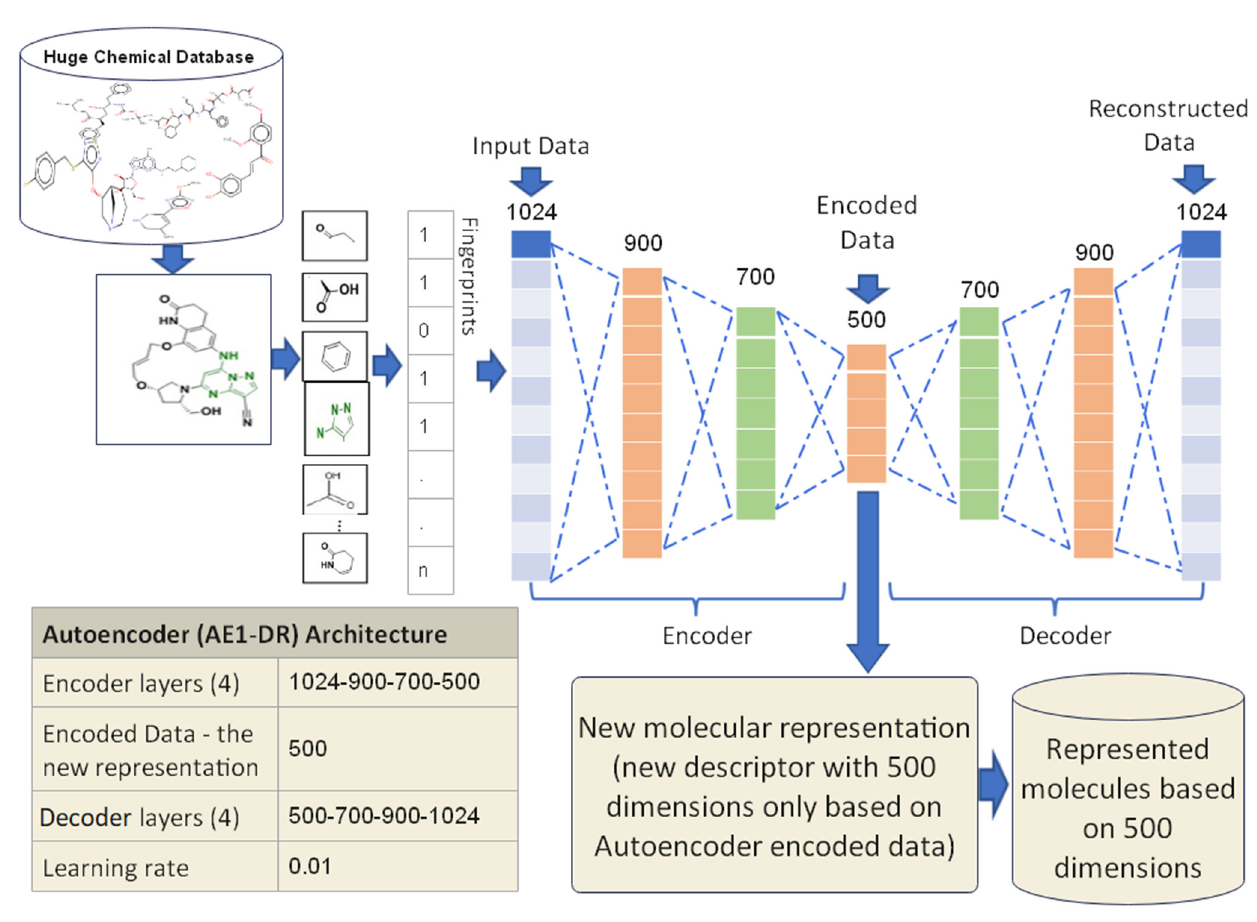
Figure 4. The AE1-DR proposed Figure 5. The AE1-DR proposed design.